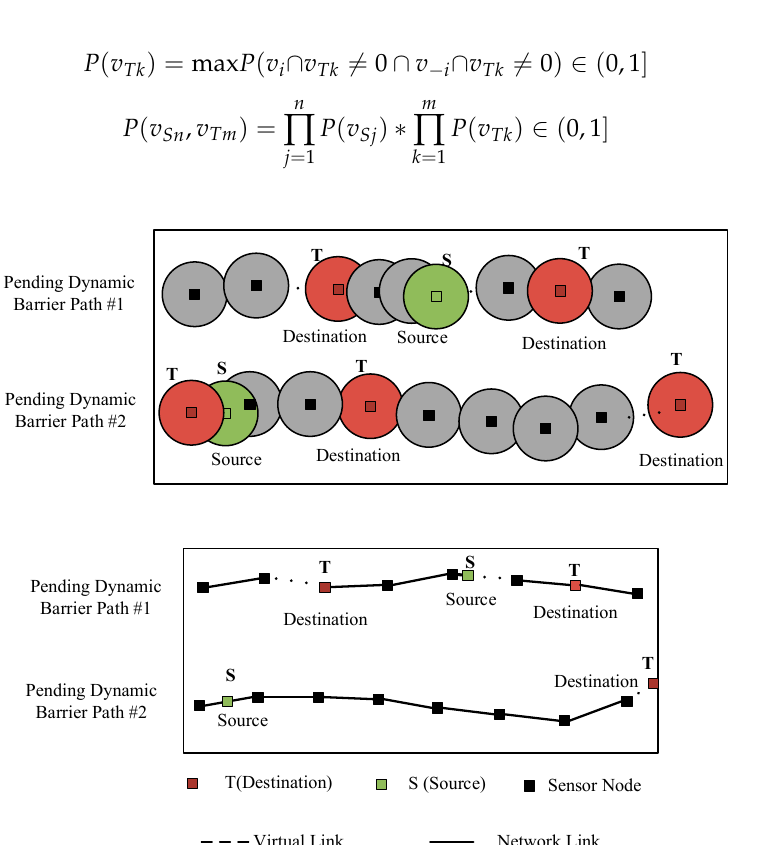
Figure 3. Pending dynamic barrier paths in coverage graph.